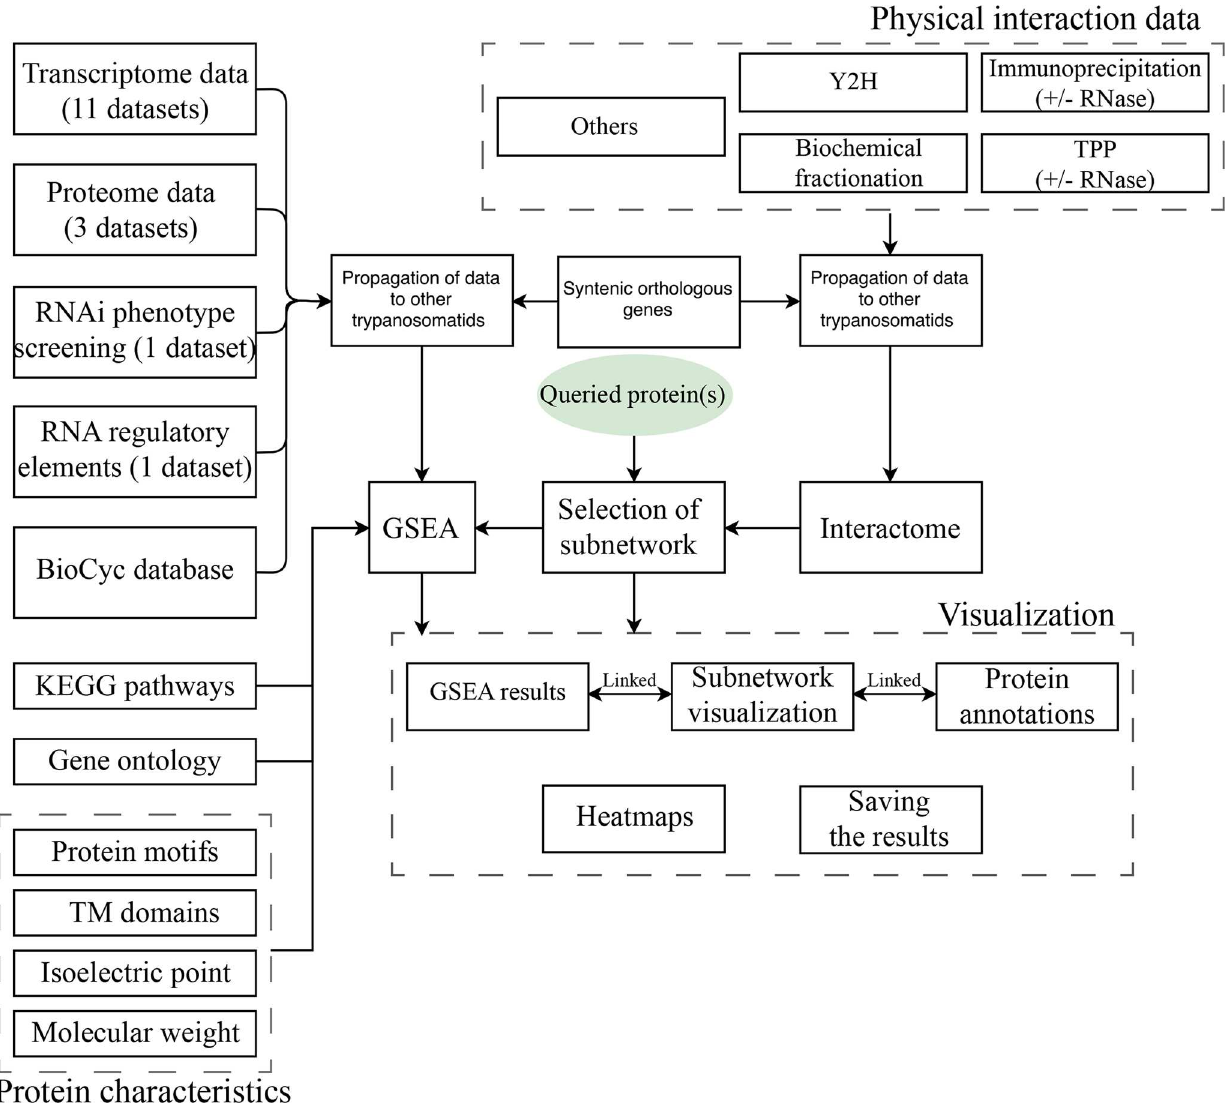
Fig 1. Architecture of TrypsNetDB. The databaseintegrates multipleresources to help functionalcharacterization of trypanosomatid proteins. GSEA: gene set enrichment analysis; TM domains:transmembrane domains;TPP: tagged protein purification. categories: 1) GO & Pathway: genes are examined for enrichment in Gene Ontology, KEGG